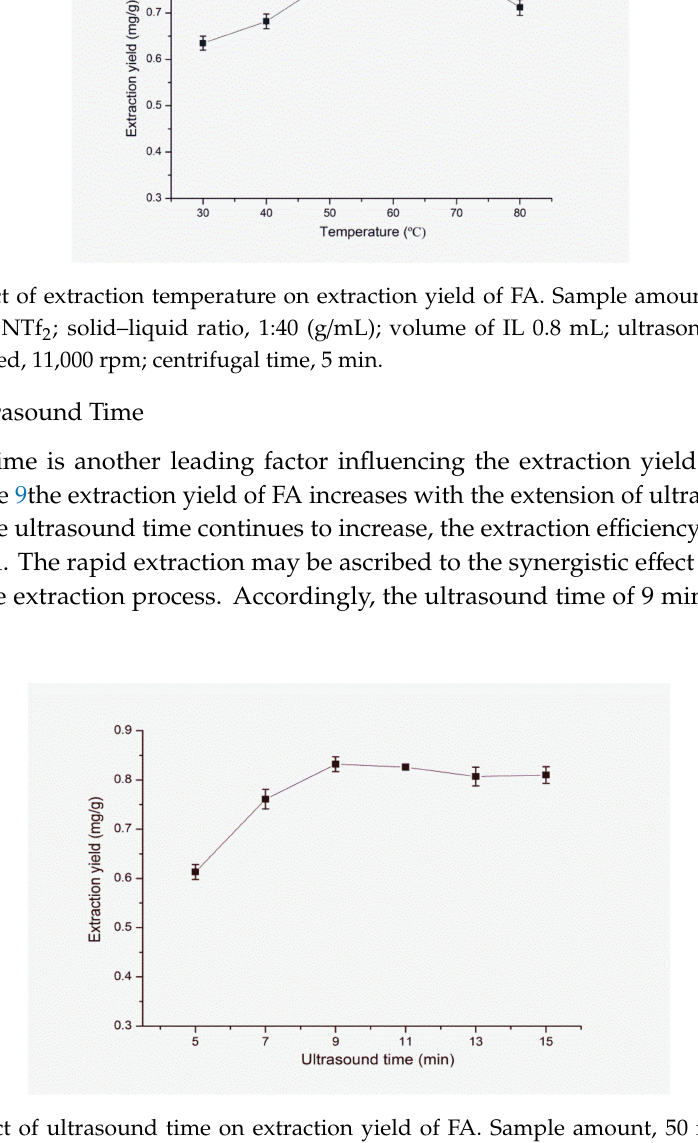
Figure 9. E ff ect of ultrasound time on extraction yield of FA. Sample amount, 50 mg; type of IL, [C 4 mim]NTf 2 ; extraction temperature, 60 ◦ C; volume of IL, 0.8 mL; solid–liquid ratio, 1:40 (g / mL); centrifugal speed, 11,000 rpm; centrifugal time, 5